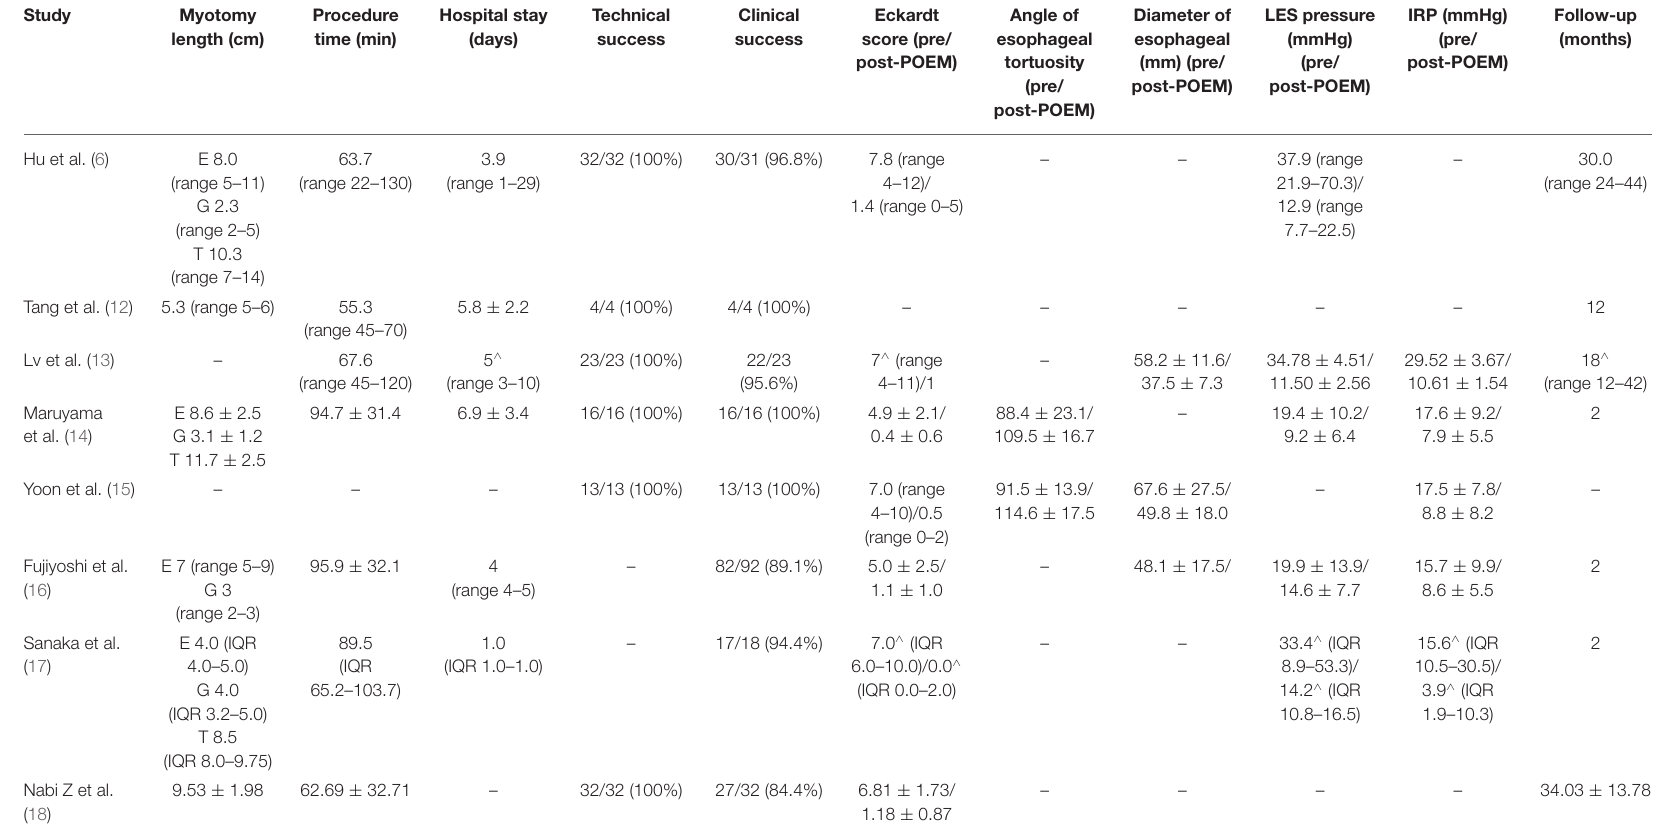
TABLE 2 | The clinical outcomes of included